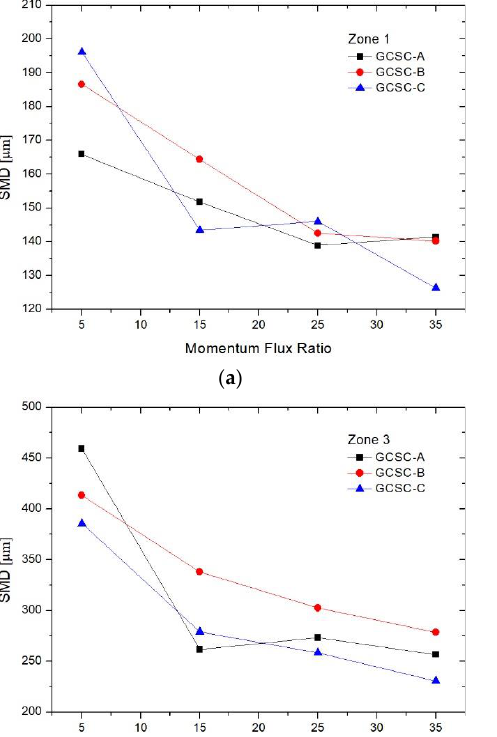
Figure 10. SMD of injectors under firing test conditions. The combustion efficiency for each injector that was calculated through combustion tests is summarized in Table 3 along with the spray visualization measurement results. The combustion efficiency represents the ratio of the experimental characteristic velocity to the ideal characteristic velocity as η 𝑐 ∗ = 𝑐 𝑒𝑥𝑝∗ 𝑐 𝑖𝑑𝑒𝑎𝑙∗ ⁄ . The combustors with GCSC-A were tested at high MFRs of 20~23, and thus, they were compared to the MFR 25 of the spray visualization test. The combustors with GCSC-B and GCSC-C were tested at MFRs equal to or less than 16, and thus, they were compared to those of the MFR 15 of the spray vis- ualization test. From the comparison, the GCSC-A with the largest MFR had the largest intensity within 2D l , the SMD was the smallest, and the combustion efficiency was the